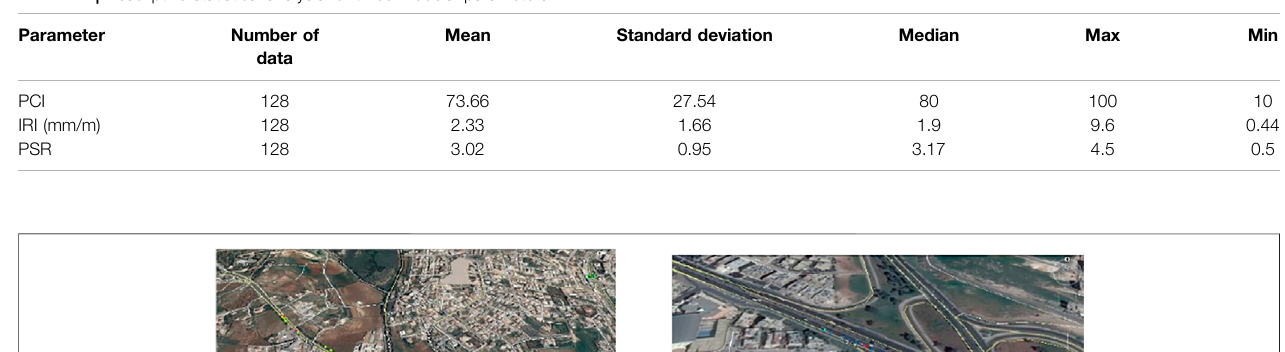
TABLE 1 | Descriptive statistical analysis for three models ’